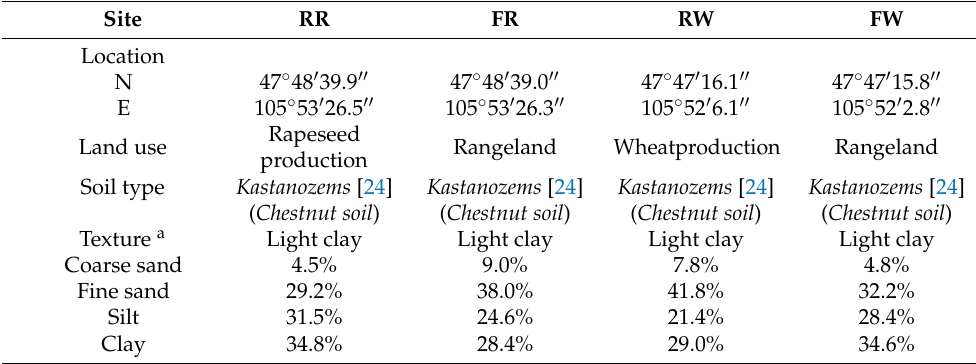
Table 1. Characteristics of the four study sites in